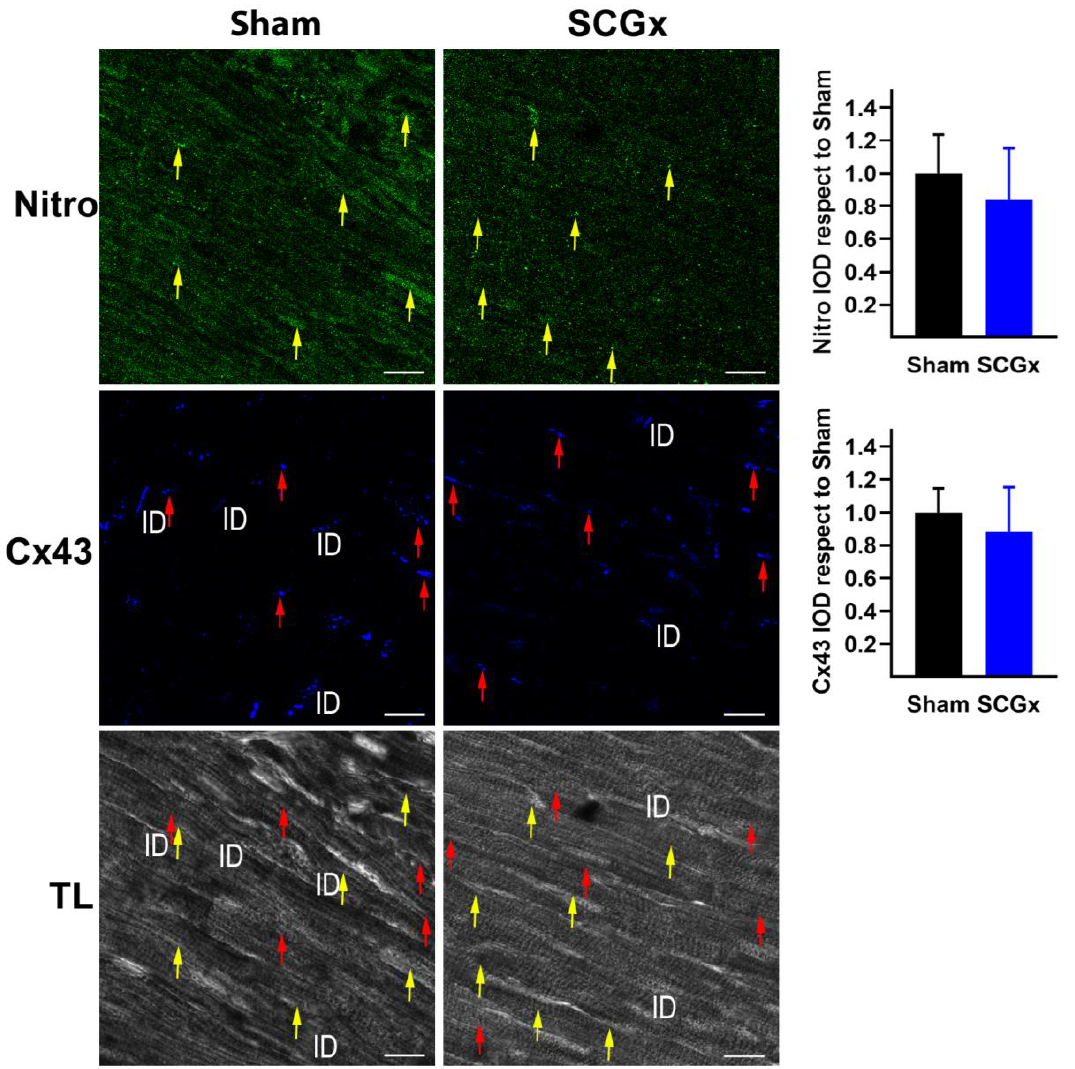
Figure 7 . Myocardial nitroxidative stress and connexin 43 (Cx43) after bilateral SCGx. Nitrotyrosine (Nitro) did not change between groups (yellow arrows). Sham hearts showed Cx43 mainly at the intercalated discs (ID), and a scarce signal was also observed at the lateral levels of myocytes (red arrows). SCGx reduced Cx43 at ID, and most of the signal was located at the lateral borders of the myocytes. Bars in the right-hand column indicate the mean integrated optical density (IOD) and SEM values relative to the level measured in the Sham group. The white scale bars in the lower right corners indicate 20 µM. In both groups, a total of 18 pictures were analyzed, six from three different hearts.